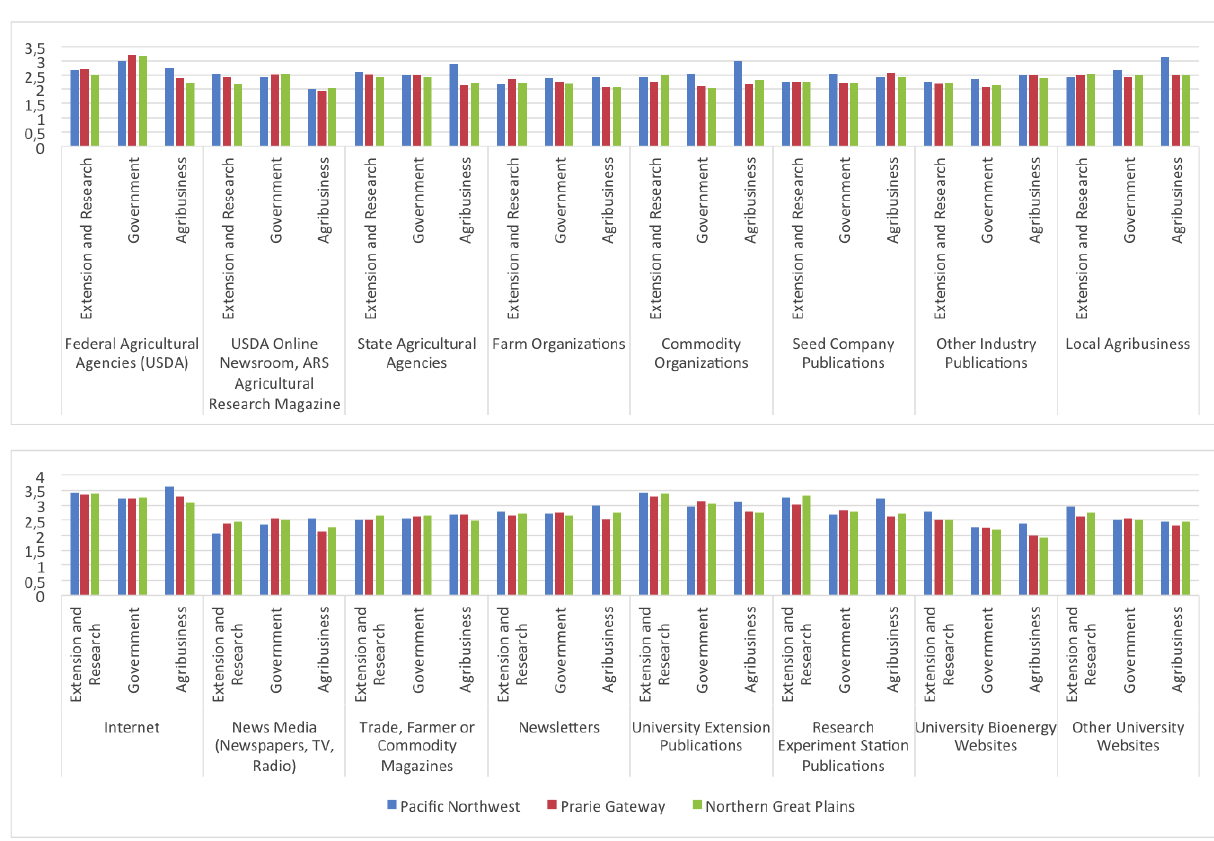
Figure 2: Mean effectiveness of information sources used by extension educators and other outreach personnel to obtain crop-related infor- mation measured on a Likert Scale: 1= not effective, 2= somewhat effective, 3= effective, 4= very effective. (Sample size for each region is: Pacific Northwest N = 130; Prairie Gateway N = 433; and Northern Great Plains N =